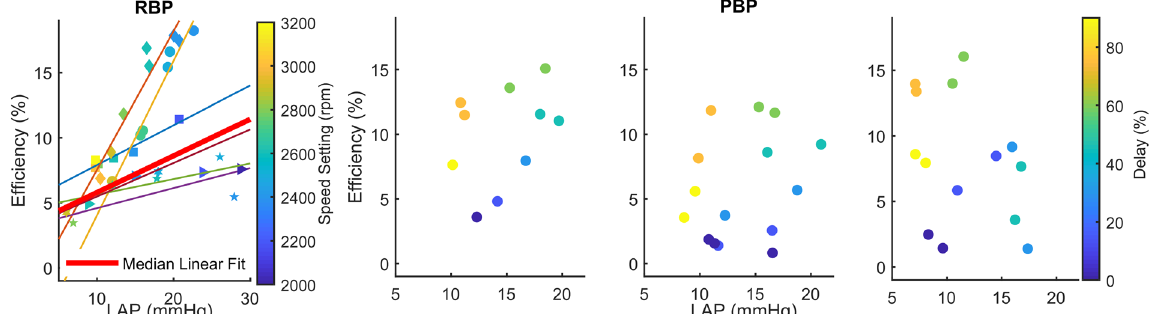
Figure 4. Relationship between LAP, pump speed, and cardiac efficiency for 6 experiments (visualized by different symbols) with an RBP. The linear regression relationship for each of the 6 experiments as well as the median linear fit is indicated (left); Relationship between LAP, cardiac efficiency, and phase delay for 3 experiments with a PBP (right). Starting in the left lower corner of each panel, the relationships develop in a counter-clock wise manner with increasing phase delay.